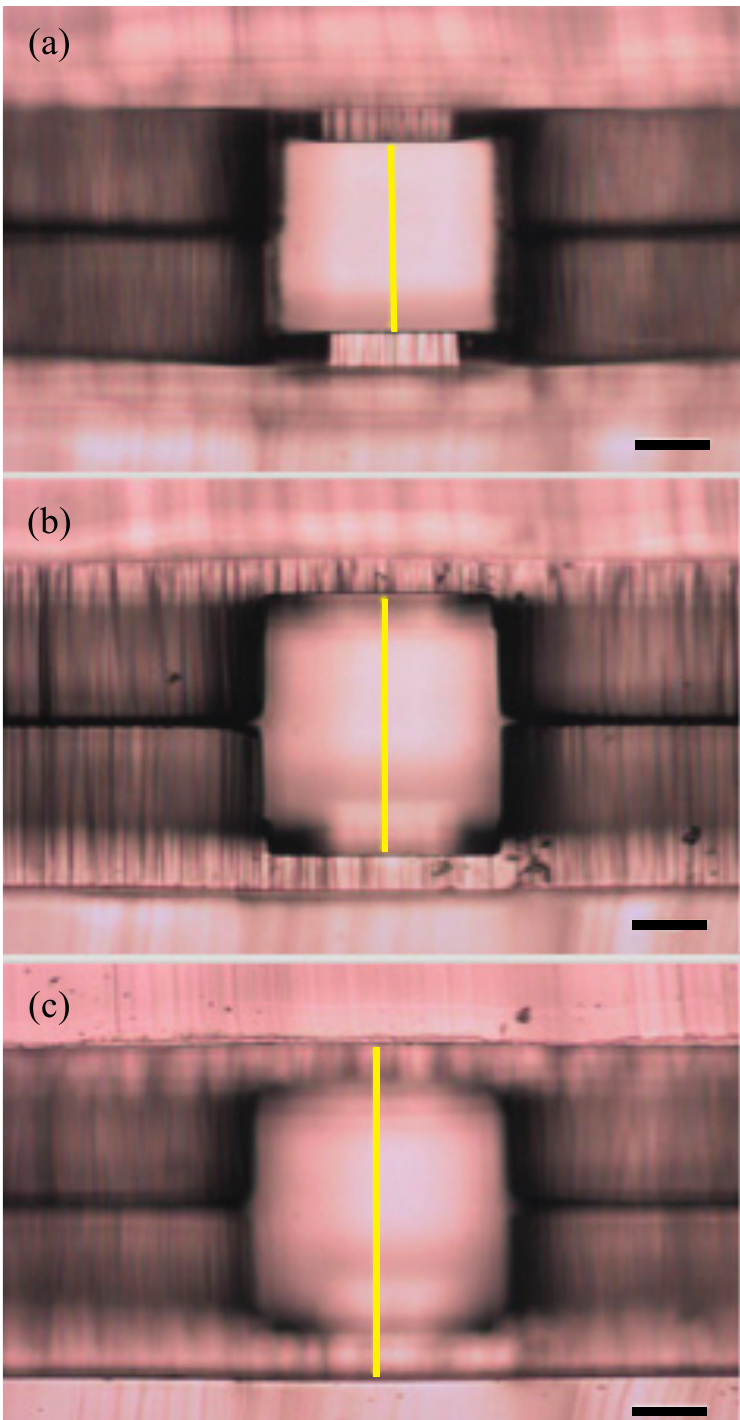
Figure 2. Different nozzle channel heights to ensure correct spatial distribution of core and shell. ( a ) Core channel height, 250 μ m; ( b ) shell channel height, 350 μ m; ( c ) oil channel height, 450 μ m. Yellow line represents the height of each channel. Scale bar, 100 μ m. Table 1. Resist formulation, maximum spin coating speed, and desired channel height for device design.